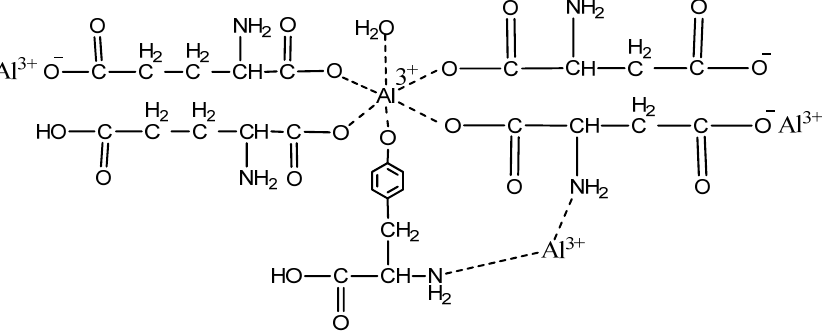
Figure 2. The possible metallocomplex formation between a metalloprotein and an aluminum ion.